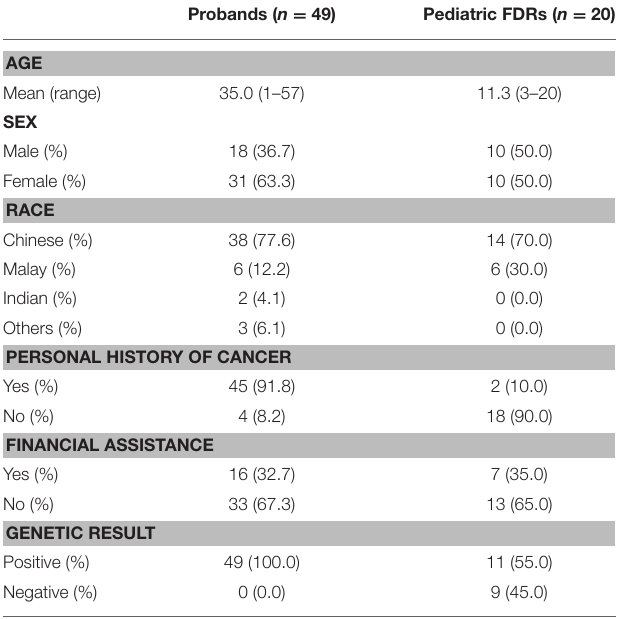
TABLE 2 | Demographic and clinical factors of probands and tested pediatric